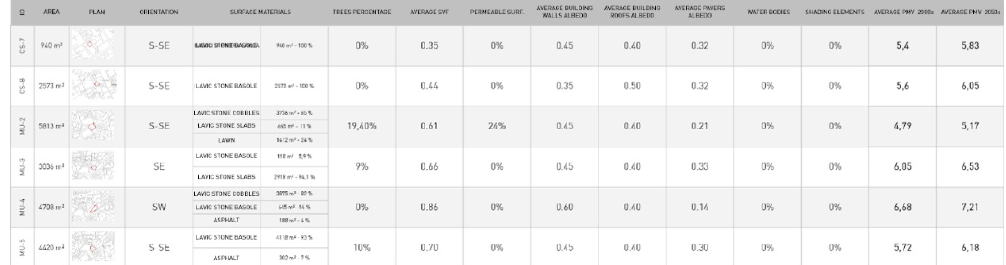
Figure A6. Extract from the matrix of technological and morphological knowledge of sample urban elements.